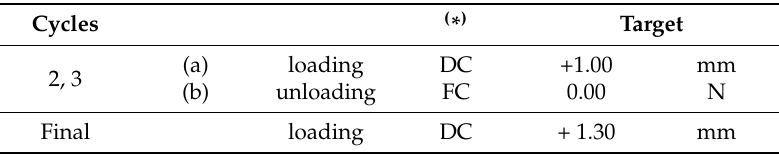
Table 11. Multi-step testing procedure for numerical experiment.